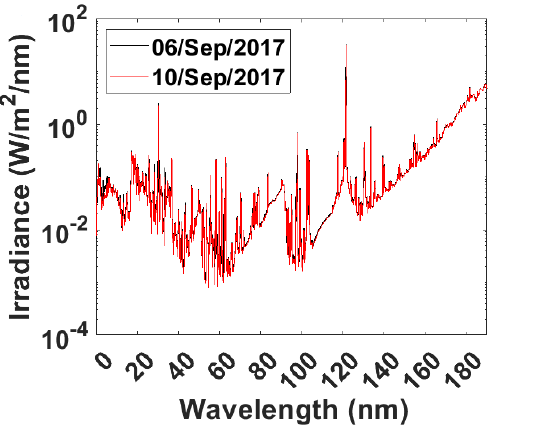
Figure 1. FISM2 radiation data summed over 24 h for all wavelengths for flares on 6 September 2017 and 10 September 2017.